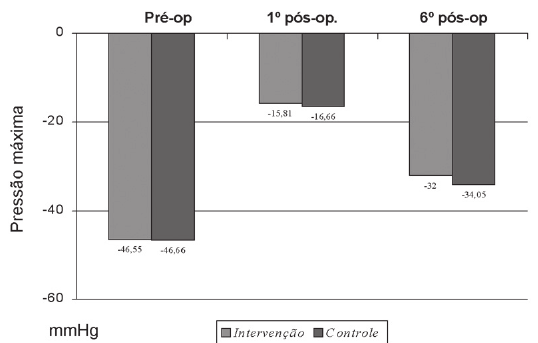
Fig. 2 - Mudanças da Pressão inspiratória máxima (Pimáx.) no pré, 1º e 6º pós-operatório. Pi=pressão inspiratória máxima.